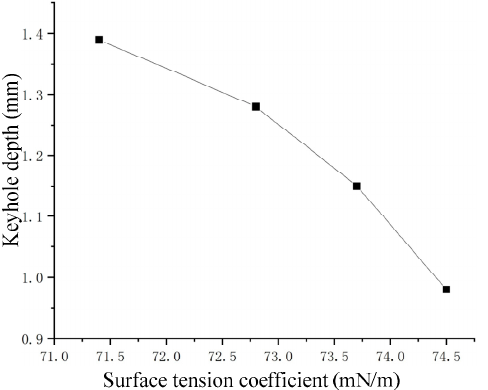
Figure 10. Keyhole depth corresponding to different surface tension coefficients.